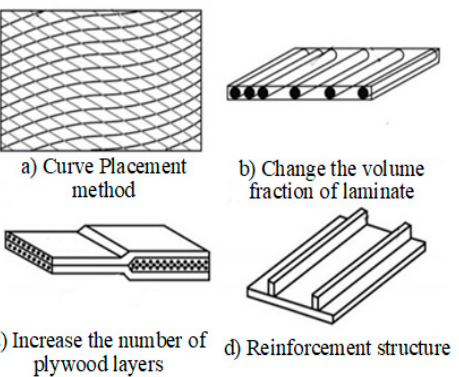
Figure 1. Four forms employed to achieve variable-stiffness laminates. ( a ) Cure placement method; ( b ) Change the volume fraction of laminate; ( c ) Increase the number of plywood layers; ( d ) Reinforcement structure.